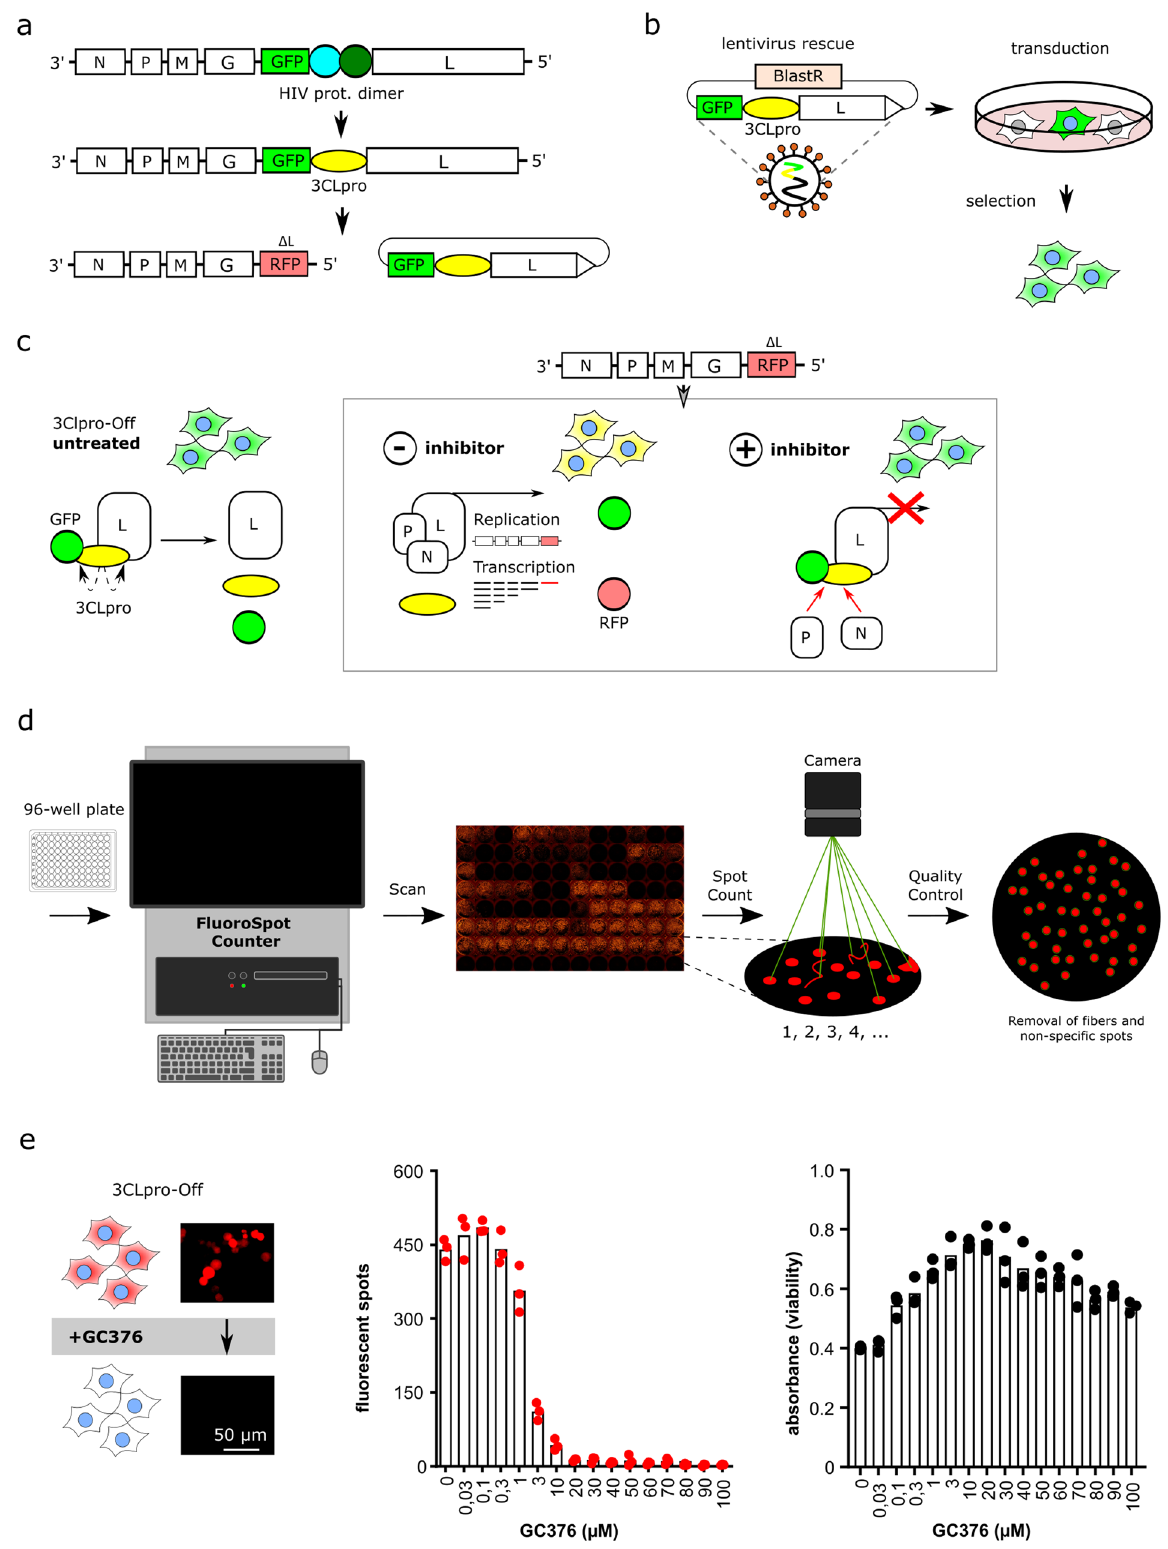
Fig. 1 Design principles of the inhibitor-off system for quantifying 3CLpro activity and chemical inhibition. a – c Schematics of the constructs leading to the current biosafety level 1 system consisting of VSV- Δ L-dsRed and Lenti-GFP-3CLpro-L with blasticidin resistance cassette (BlastR). Lentiviral transduction yields GFP-positive cells, and subsequent infection with VSV- Δ L-dsRed particles yields GFP/dsRed-positive cells (yellow in merge). Addition of a 3CLpro inhibitor suppresses the accumulation of dsRed signal (inhibitor-off system). d Schematic of FluoroSpot Counter work fl ow to generate high- throughput data. e GC376 causes a dose-responsive suppression of dsRed signal (inhibitor-off) and a corresponding restoration of cell viability ( n = 3 biologically independent replicates per condition with individual data points shown and average values represented by histogram bars).